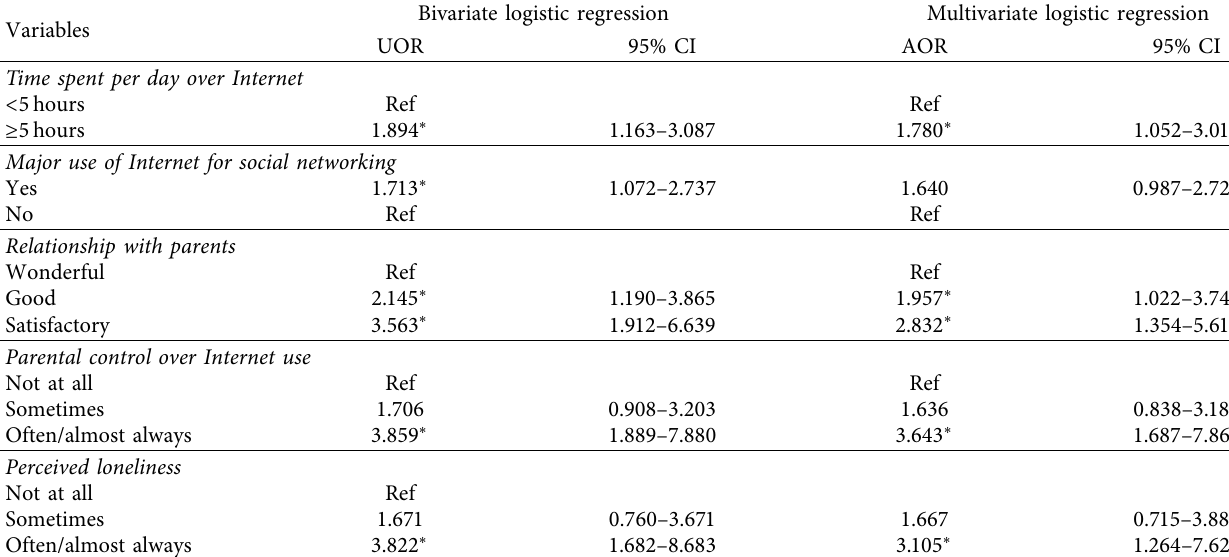
Table 7: Predictors of Internet